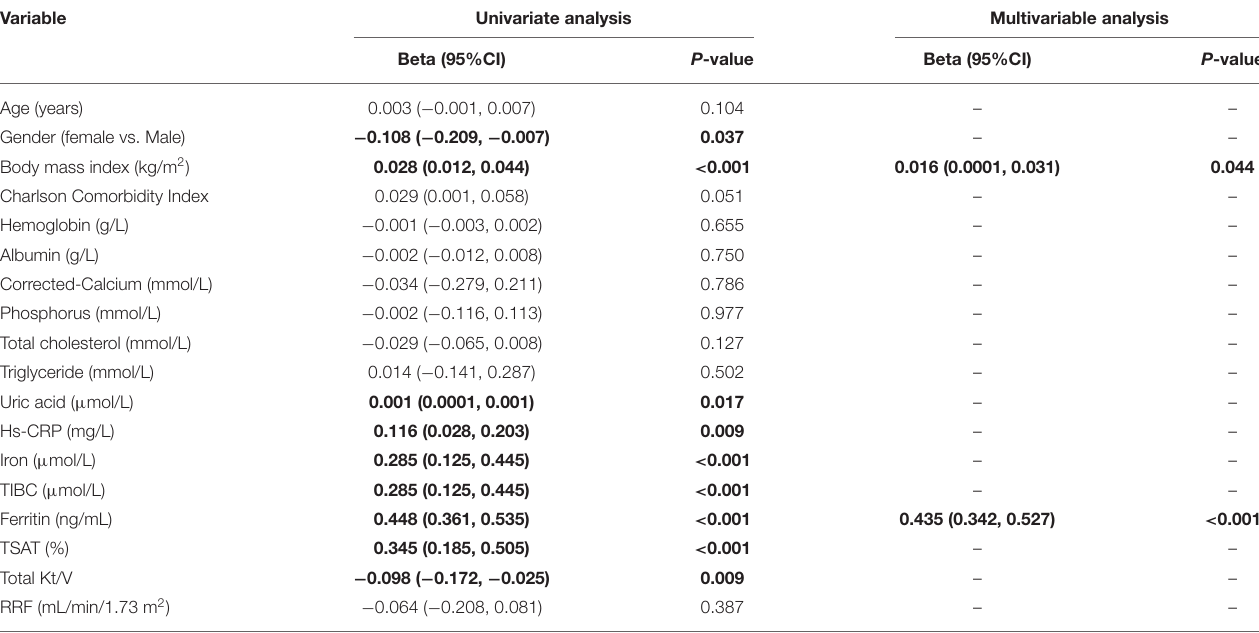
TABLE 2 | Clinical and laboratory factors associated with serum hepcidin-25 concentration # .